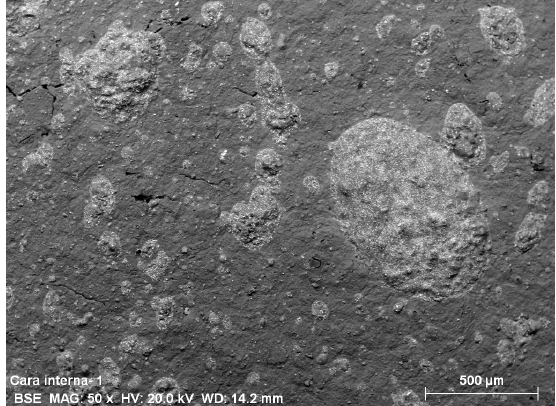
Figure 15. SEM of the ceramic tile’s hidden face applying 50 magnifications.